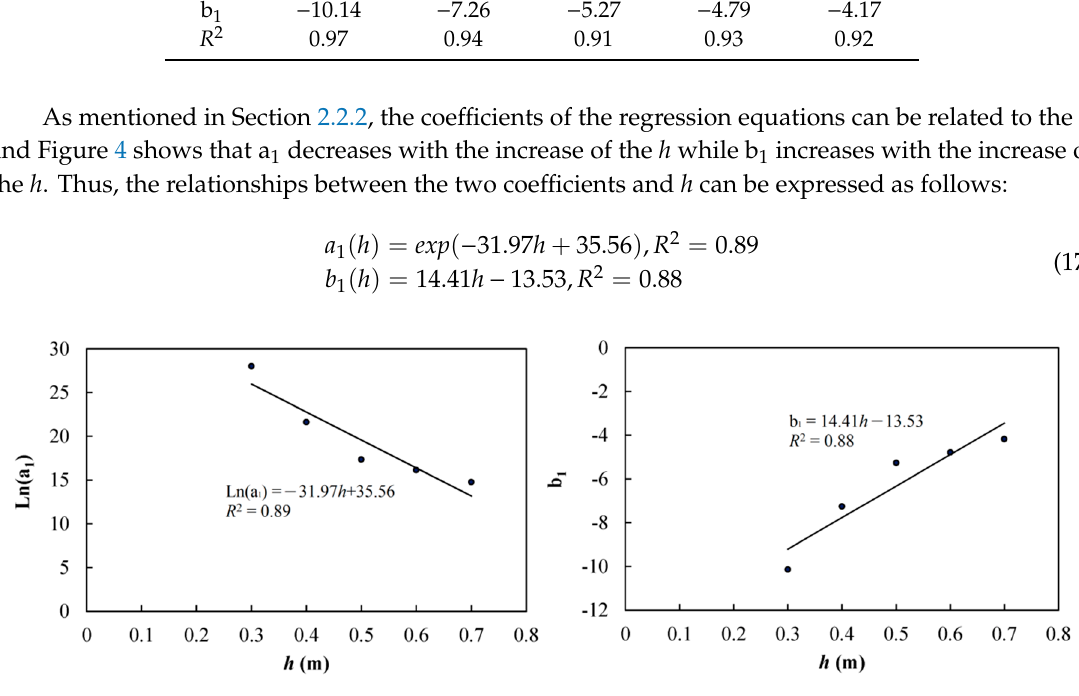
Figure 4. Relationship between the two coefficients of the regression equation for calculating the residence time ( RT ) and the height of the weir ( h ).